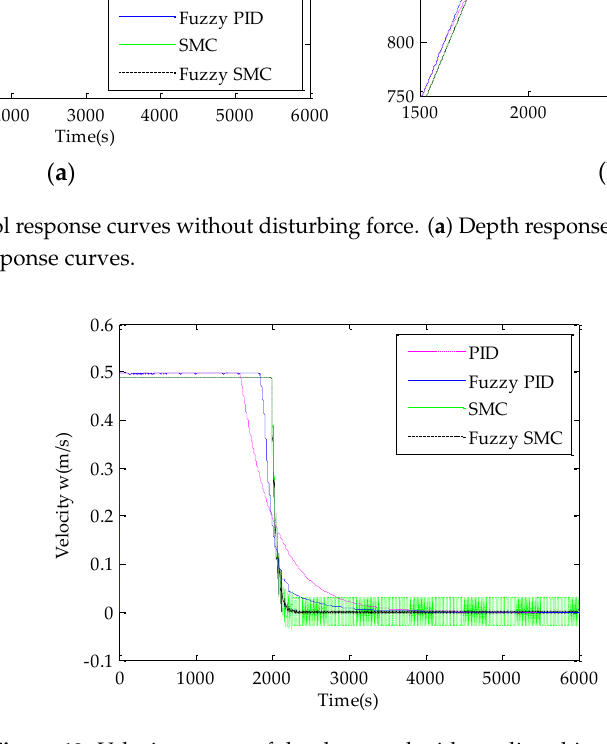
Figure 12. Velocity curves of depth control without disturbing force. Table 7. Characteristic parameter table of four controllers.